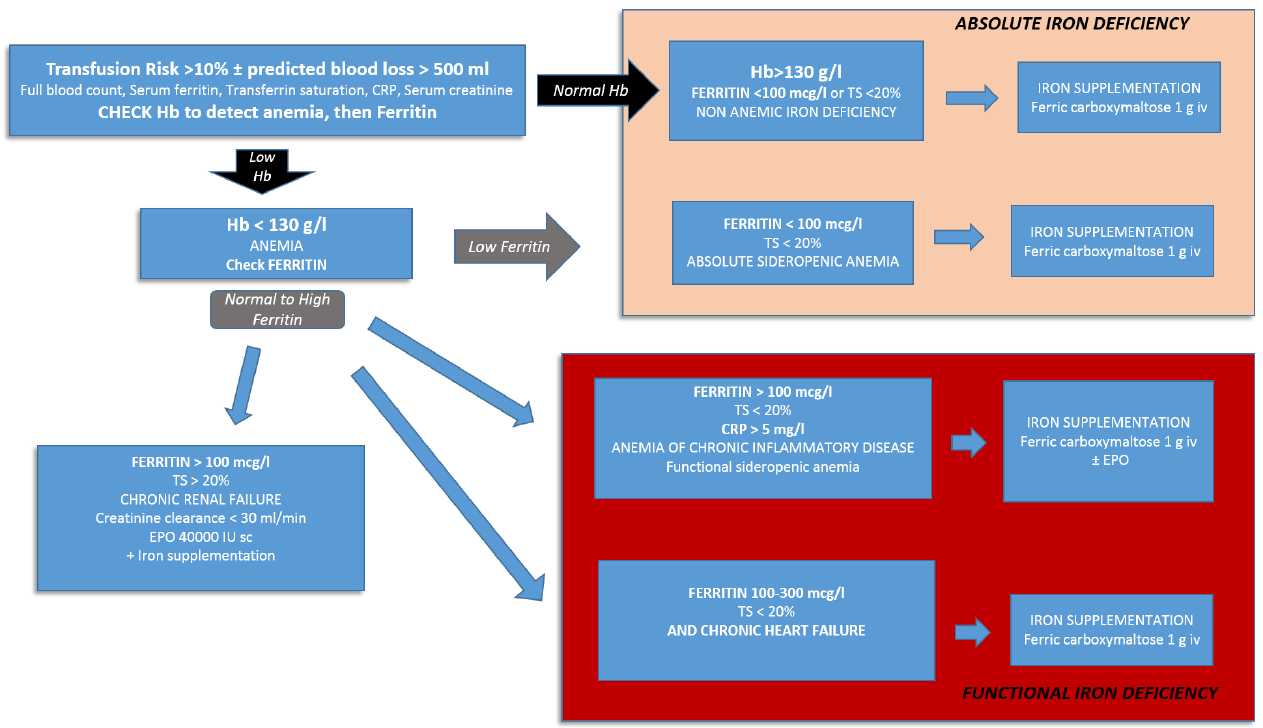
Figure 1. Algorithm for anemia management in the cardiac surgical population. CRP = serum C-reactive protein, Hb = hemoglobin, TS = transferrin saturation, EPO = Erythropoietin. Note: the higher ferritin cut-off of 100 mcg/L is used to identify absolute iron deficiency since the high prevalence of an inflammatory state in the cardiac surgical